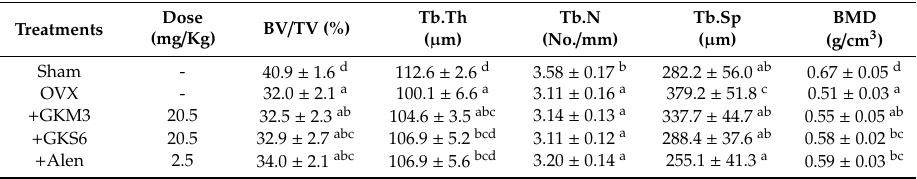
Figure 2. Representative Micro Computed Tomography images of Femur in (A) Sham group, (B) OVX untreated group, (C) OVX + GKM3 20.5 mg / kg group, (D) OVX + GKS6 20.5 mg / kg group and (E) OVX + alendronate 2.5 mg / kg group. Table 2. E ff ects of probiotics on bone morphometric